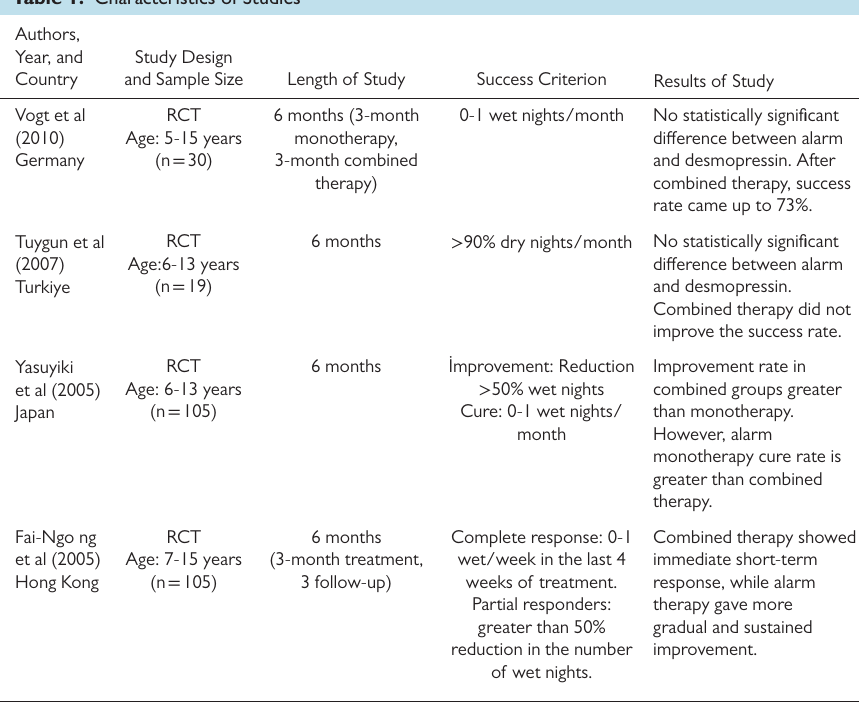
Table 1. Characteristics of